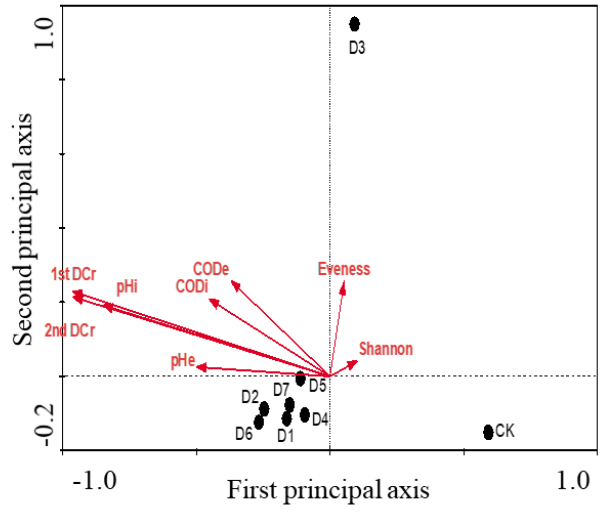
Figure 6. CCA analysis of habitat similarity of acclimatization systems with different azo dyes. DCr = decolorization rate, pHi = initial pH, pHe = final pH, CODi = initial COD, CODe = final COD, Shannon = Shannon diversity index, D1–D7 = the bacterial community structure of sludge acclimatized with methyl orange, methyl red, orange I, orange G, tartrazine, alizarin yellow R sodium salt and mixture and CK.